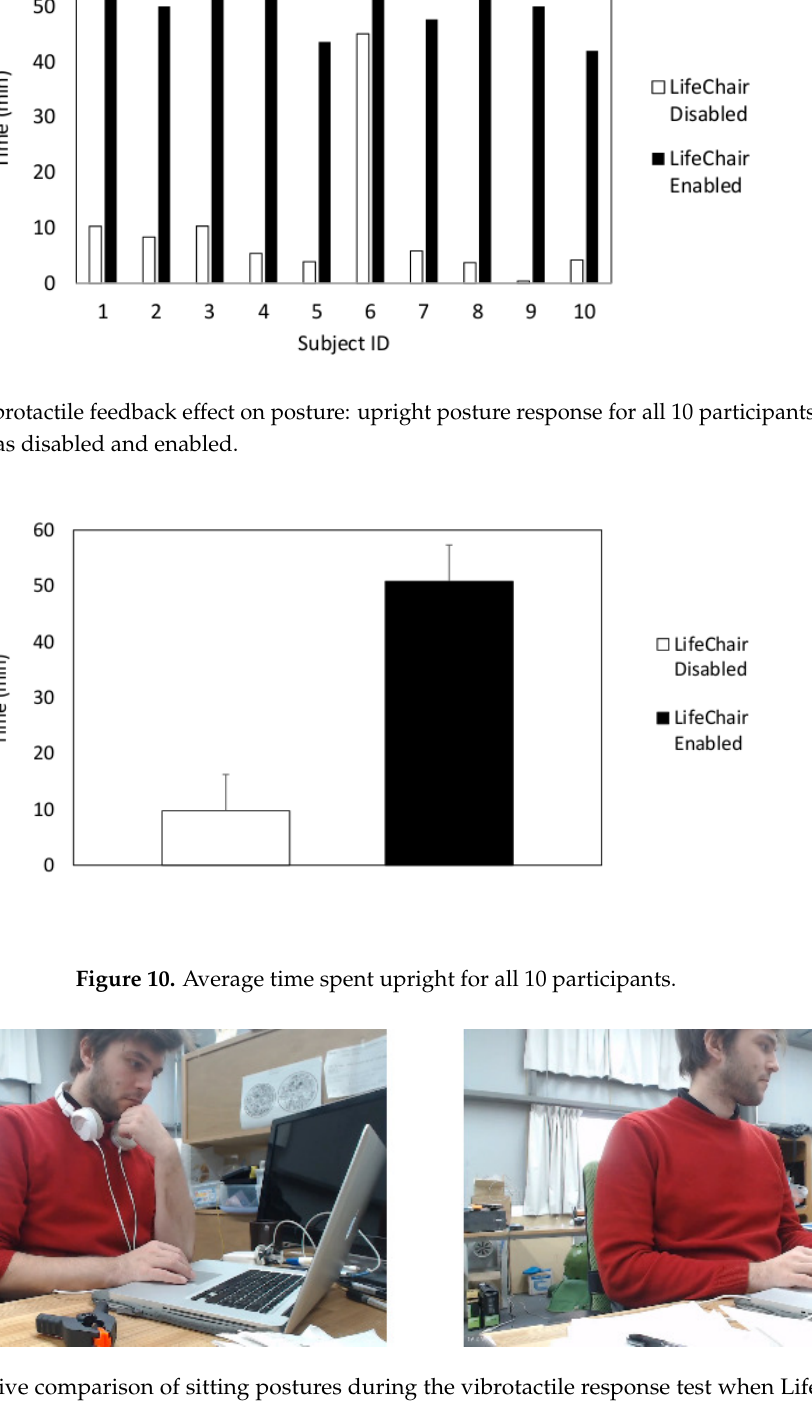
Figure 11. Live comparison of sitting postures during the vibrotactile response test when LifeChair was disabled ( left ) and when the LifeChair was enabled ( right